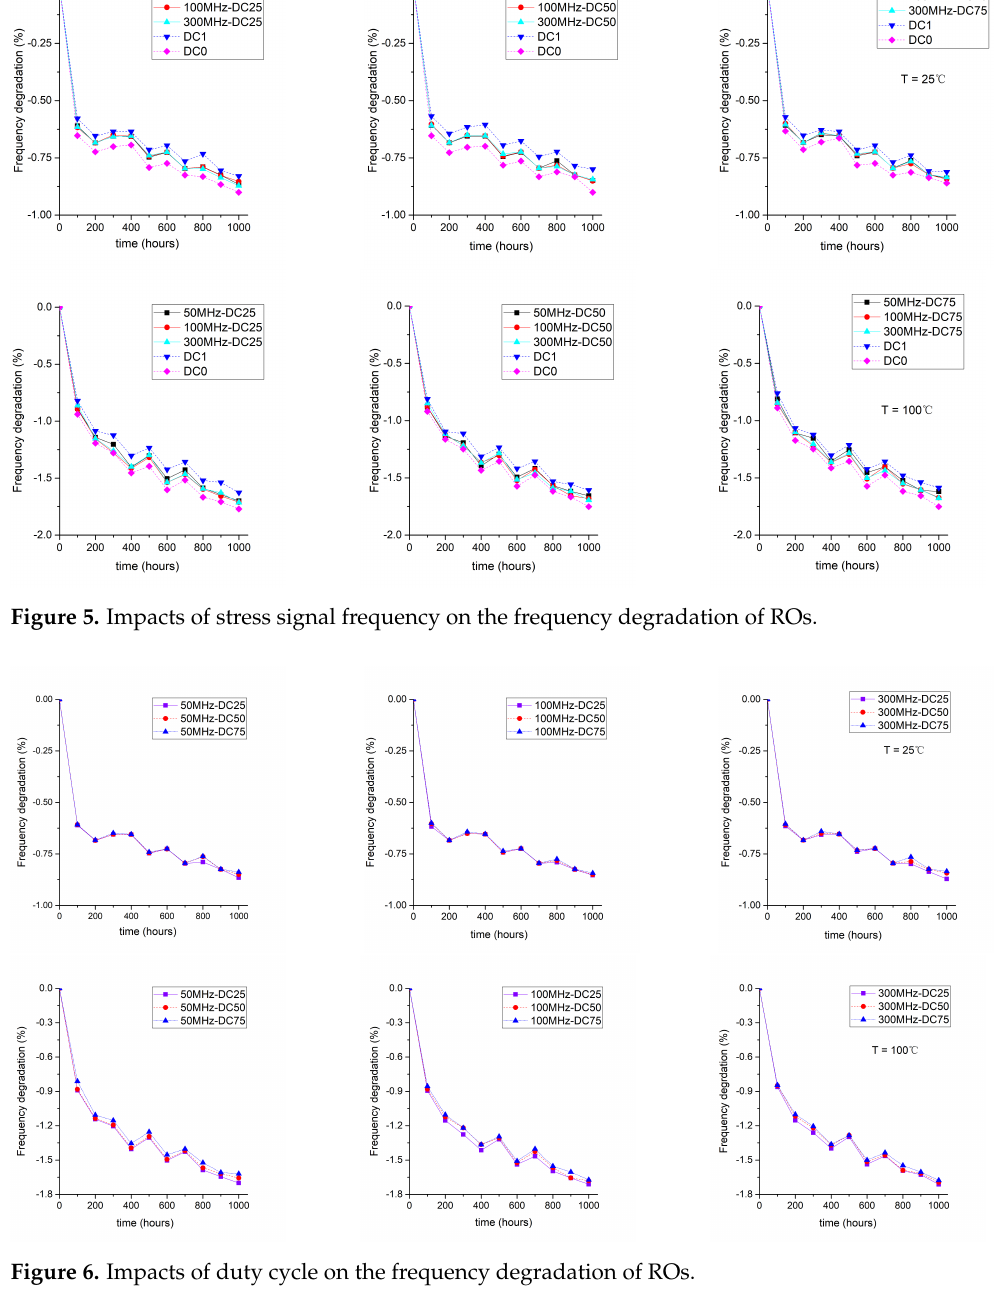
Figure 6. Impacts of duty cycle on the frequency degradation of